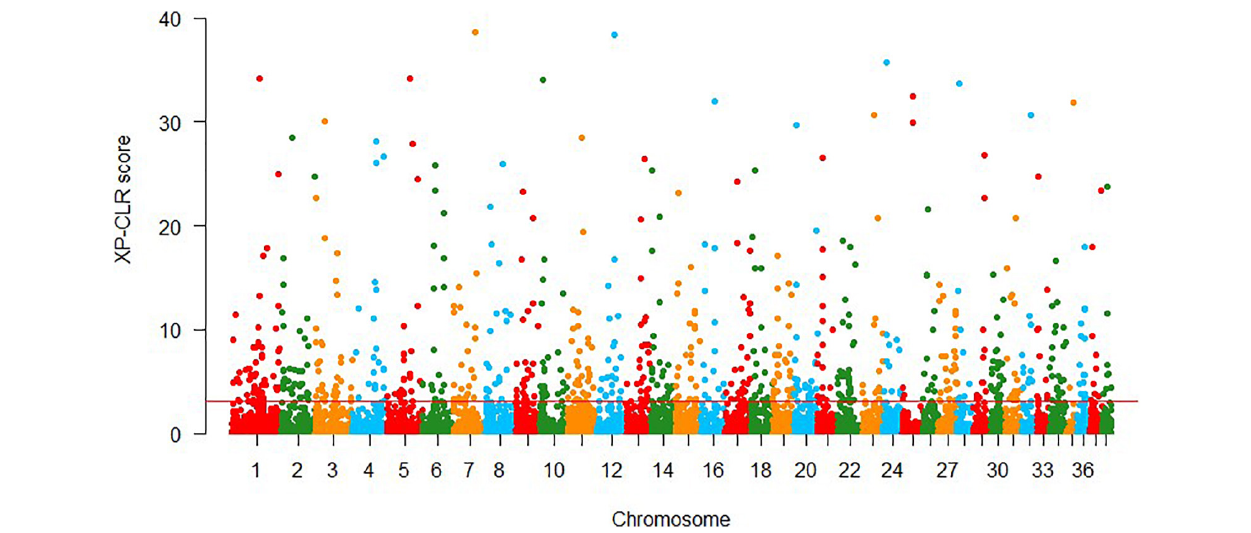
FIGURE 3 | Genomic regions with signatures of selective sweeps identified using 25-kb non-overlapping windowed XP-CLR approaches. Red line indicates the significance threshold of the top 1% (XP-CLR = 3.07). TABLE 2 | Regions showing signals of selection with the F ST , Hp and XP-CLR approaches.